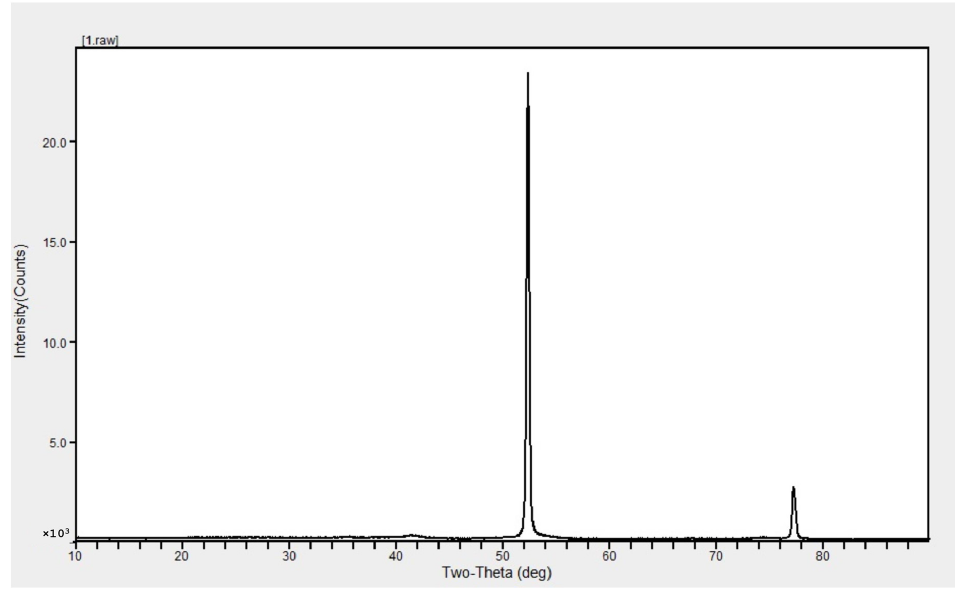
Figure 3. X-ray di ff raction pattern of Beauveria brongniartii Fe 0